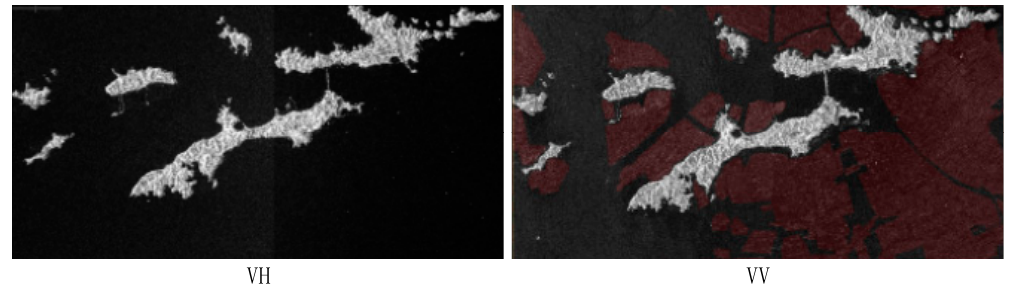
Figure 12. Sentinel-1 dual polarization imaging.